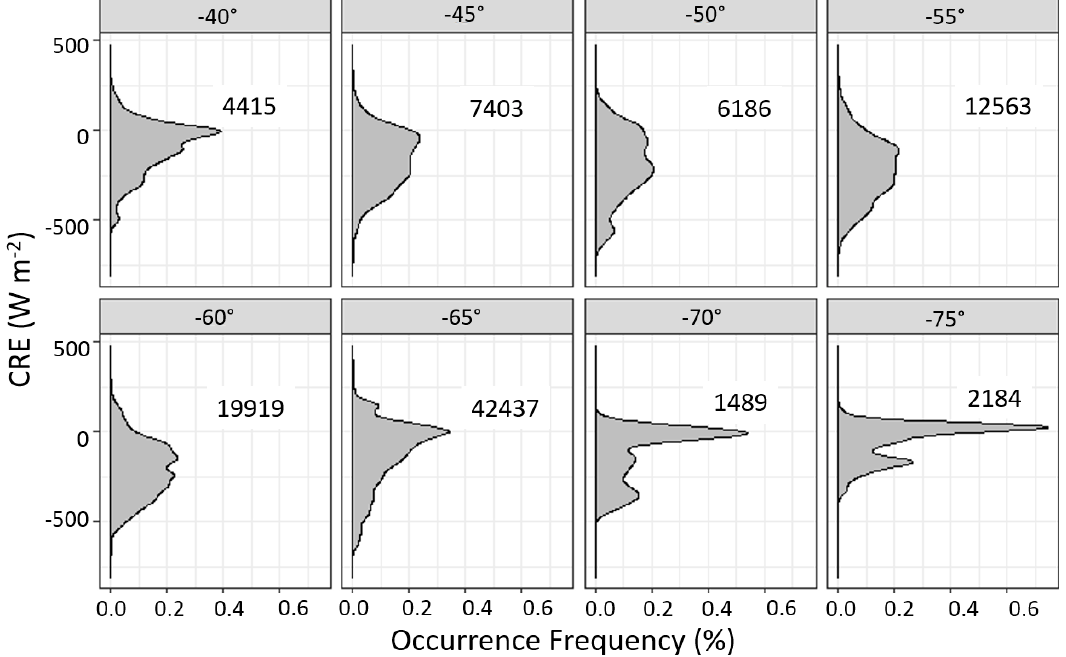
Figure 5. Histograms of 1-min averaged cloud radiative effect (CRE) as a function of percentage occurrence for different latitudes in 5-degree bands. The data are from all voyages. The latitude of each band-centre (degrees) is indicated at the top of each plot and the total number of 1-minute observations in each latitude band is indicated in each panel.